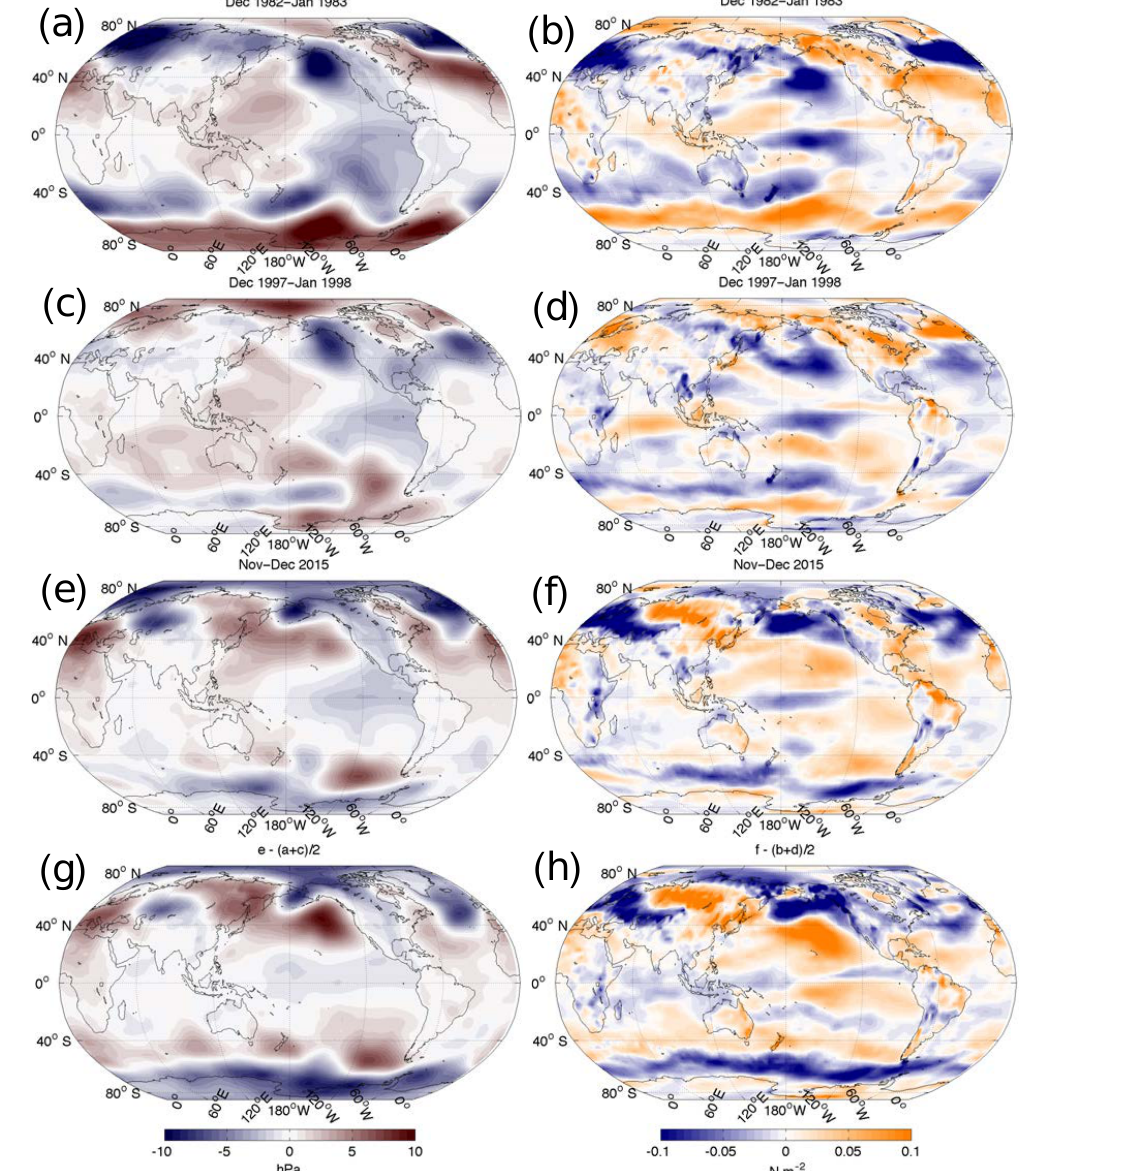
Figure 3. (a, c, e) The surface pressure and (b, d, f) zonal friction drag anomalies averaged over December–January for the 1982–1983 and 1997–1998 EP events and averaged over November–December for the 2015–2016 EP–CP event. Panels (g) and (h) show, respectively, the difference in pressure and zonal friction drag anomaly between the 2015–2016 situation and the average of the 1982–1983 and 1997–1998